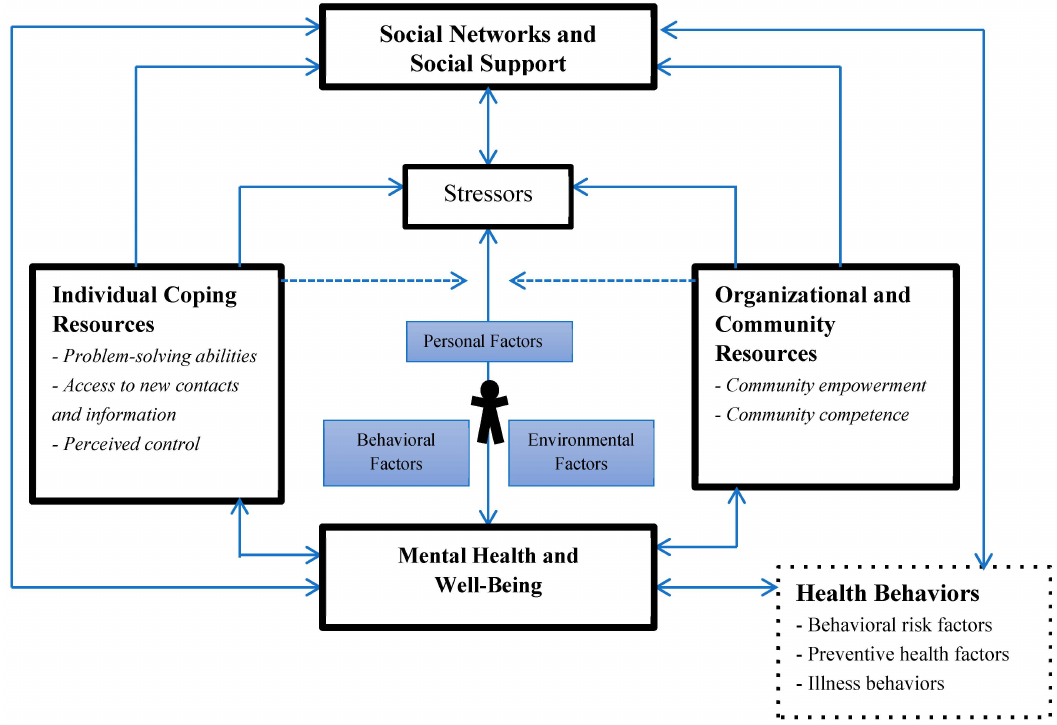
Figure 1. The integration of social cognitive theory (SCT) and theories of social networks and social support (SNSS) that inform the YBMen project conceptual